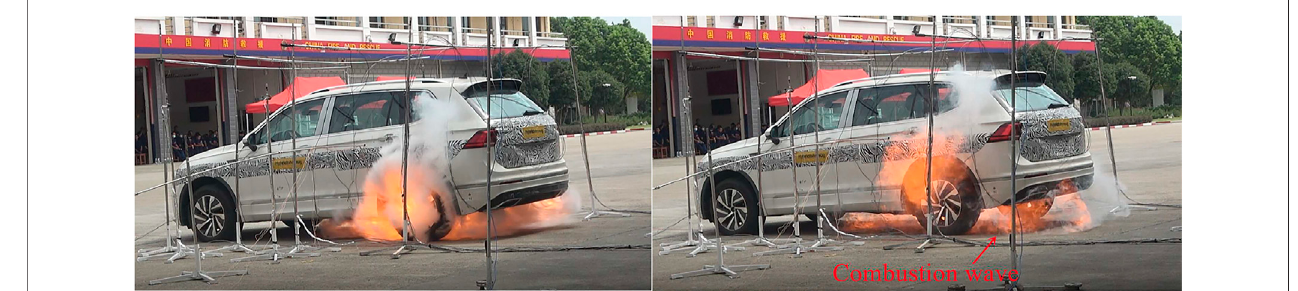
FIGURE 3 | Explosion phenomenon in Test